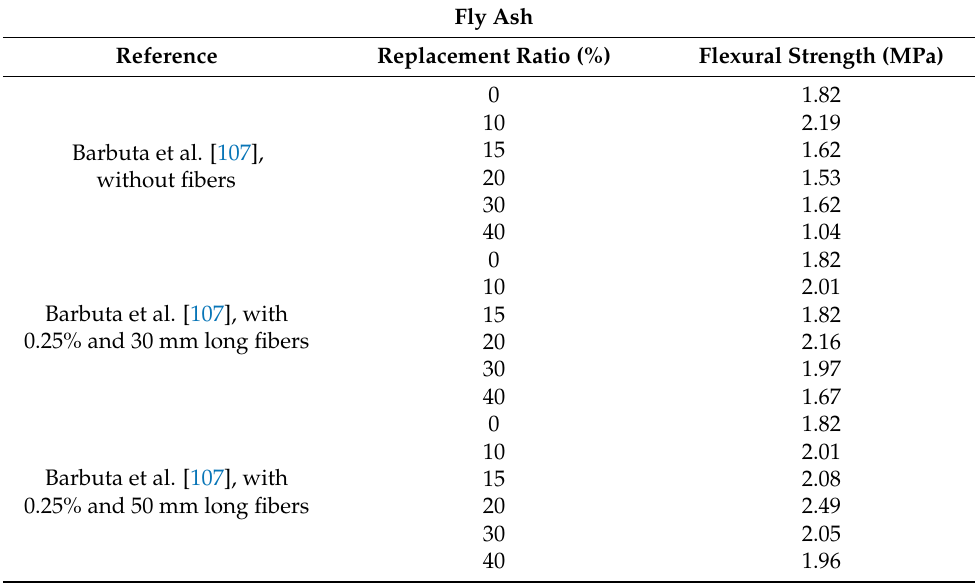
Table 4. Flexural strength (28-days) of composites containing fly